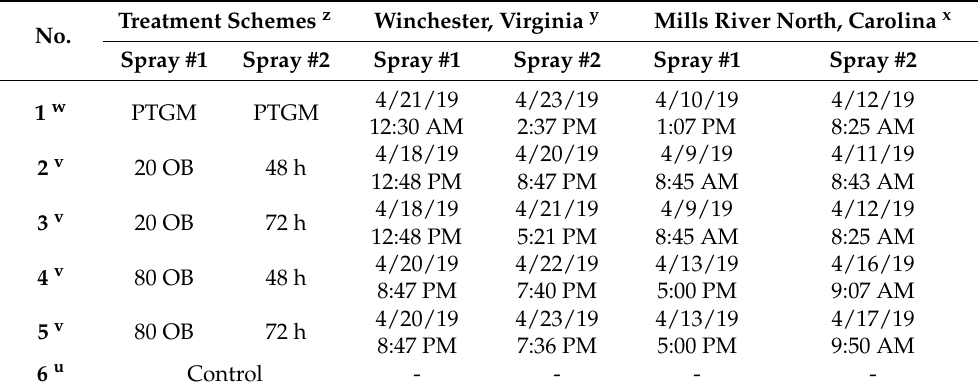
Table 1. Treatment schemes and application